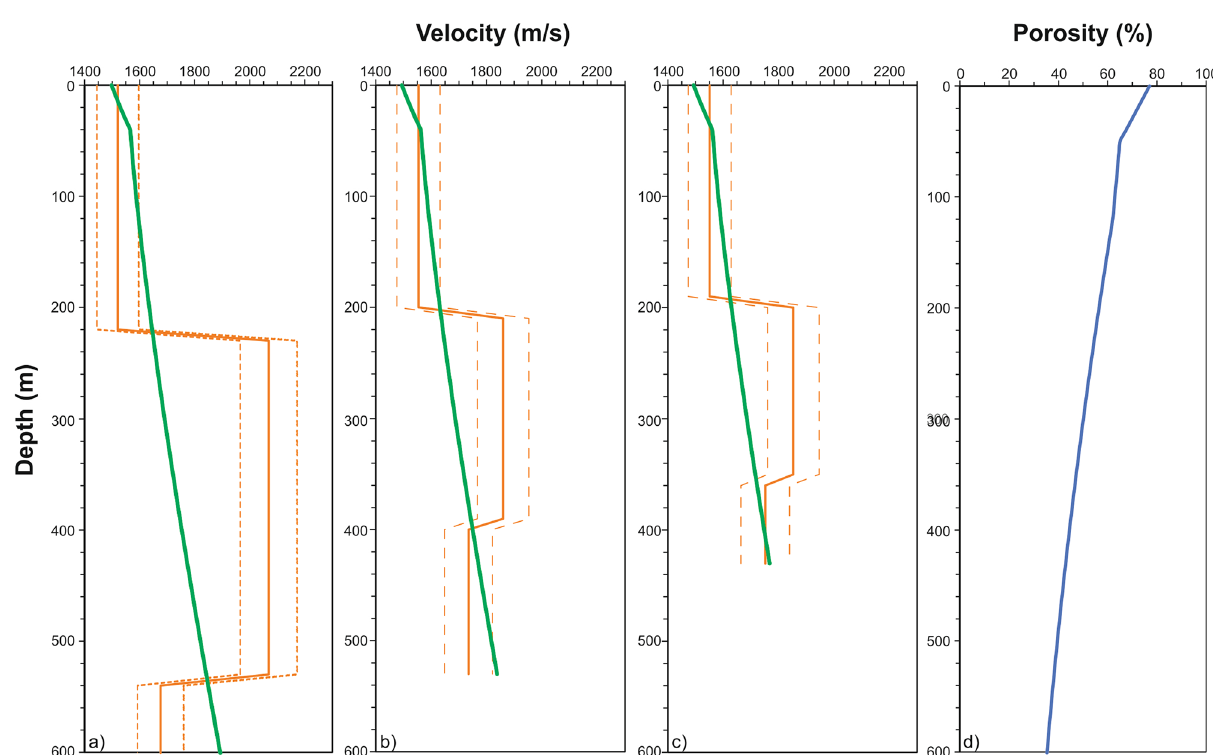
Figure 3. P velocity and porosity. ( a – c ) report seismic velocity profiles (orange line) values extracted from seismic velocity model of MGL1701-30 section, and an error of 5% (dashed lines) in the three positions shown in Fig. 2e. The green line represents the background velocity. The ( d ) reports the porosity variations versus